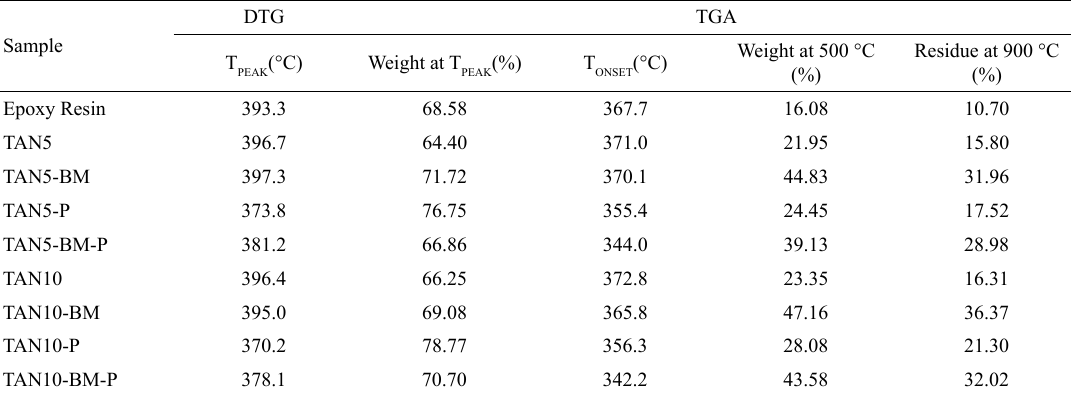
Figure 6. Thermal degradation of samples: a) TG of the TAN5 set, b) DTG of the TAN5 set, c) TG of the TAN10 set and d) DTG of the TAN10 set. Table 2. TG and DTG Data of intumescent systems under N2